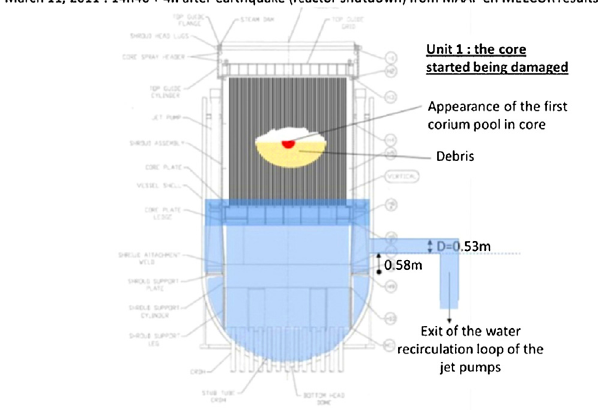
Fig. 2. Illustration of the appearance of the fi rst corium pool in the core: ∼ 4 h after the reactor